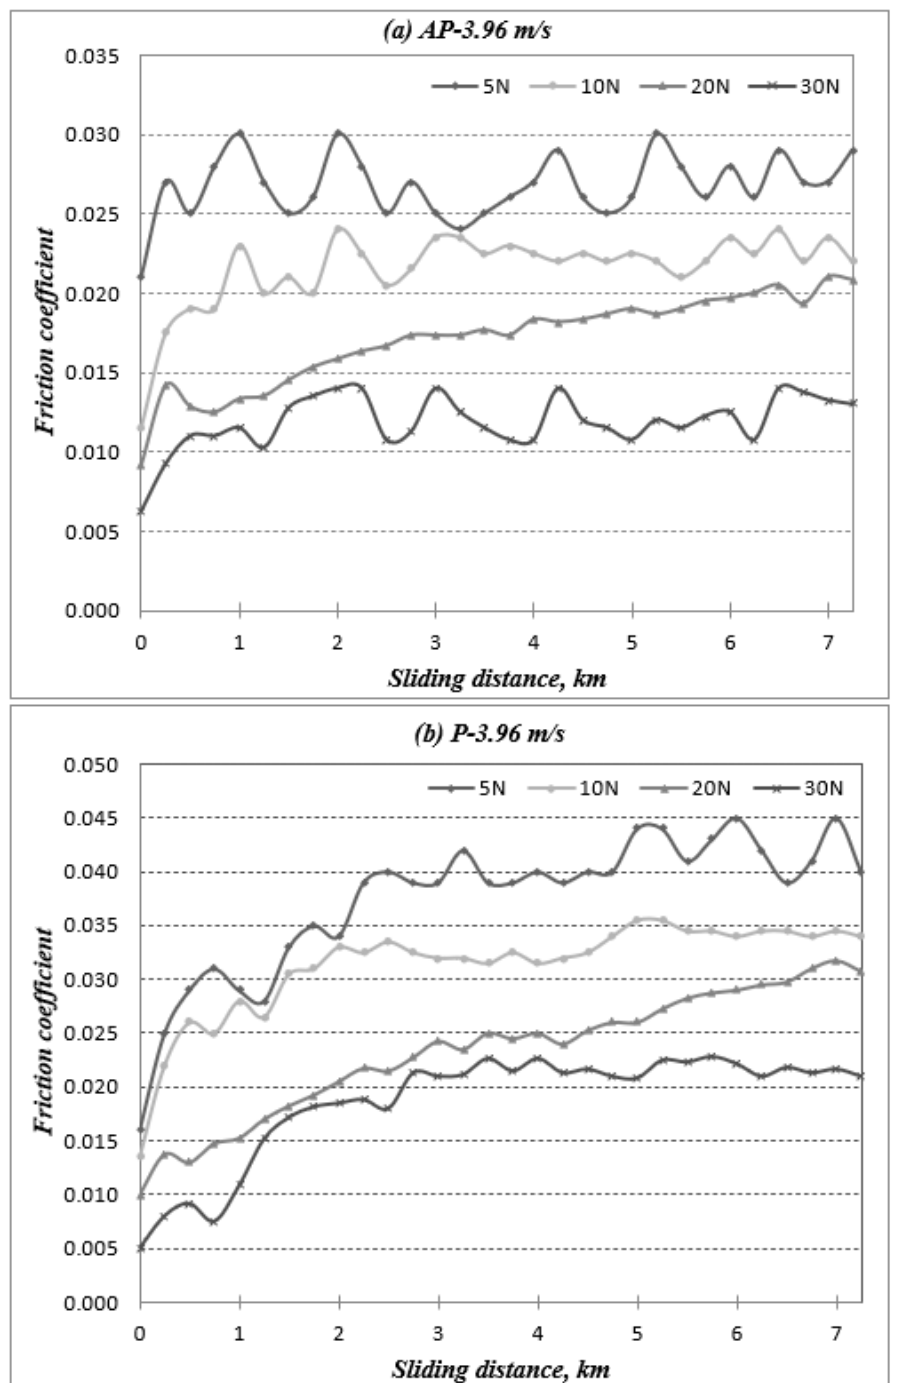
Figure A3. Friction coefficient vs. sliding distance for different fibre orientations (AP and P) subjected to different applied normal loads at 3.96 m/s of sliding velocity.